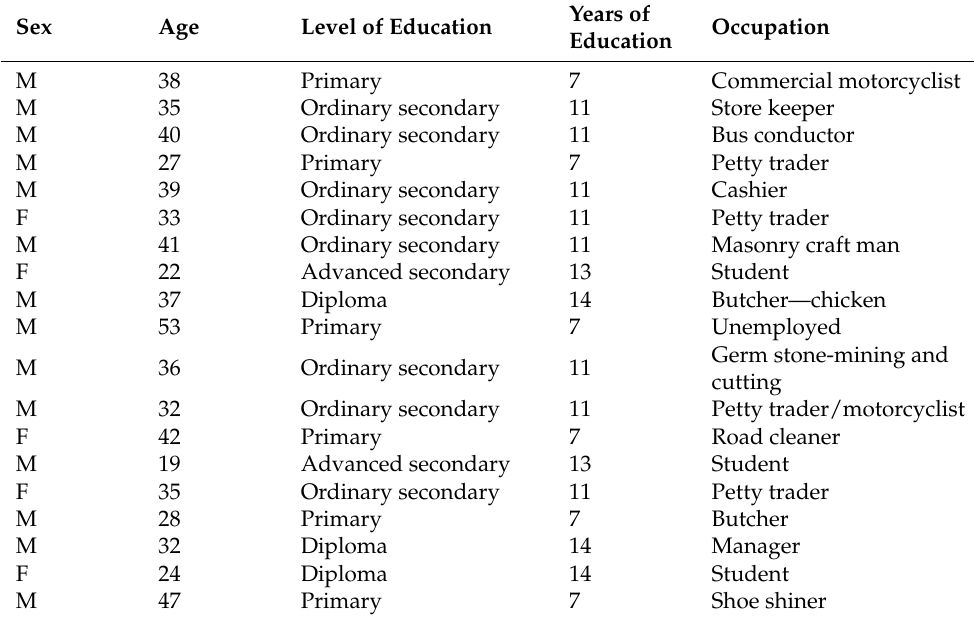
Table 2. Demographics of study participants.